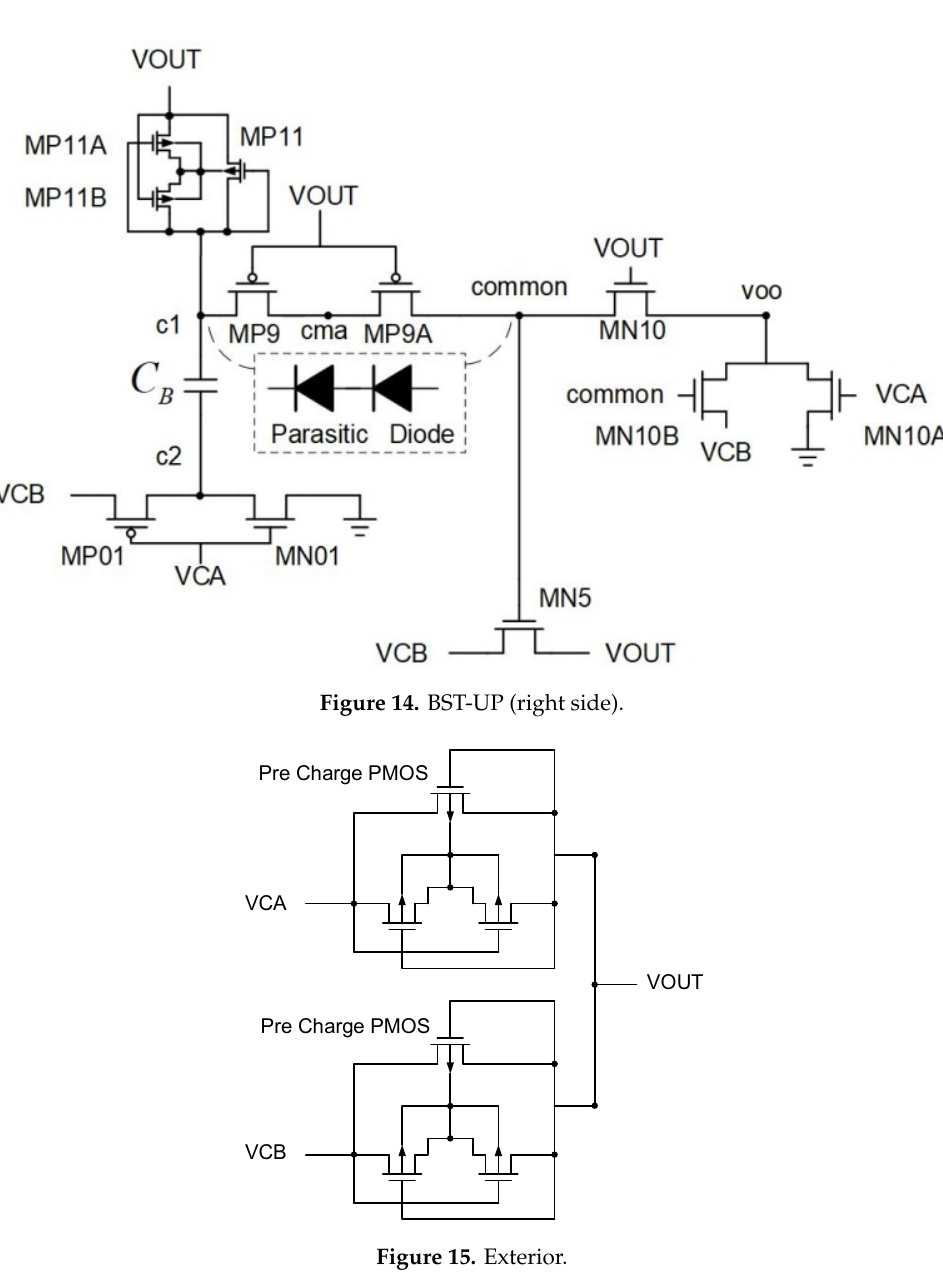
Figure 13. Bootstrap circuit diagram (proposed version).